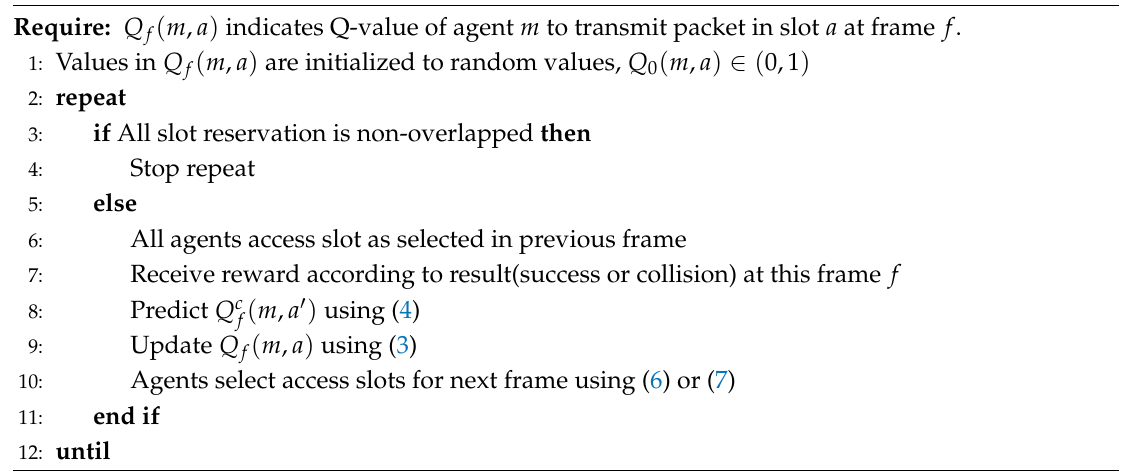
Algorithm 1 Slot assignment using collaborative Q-learning in IoT